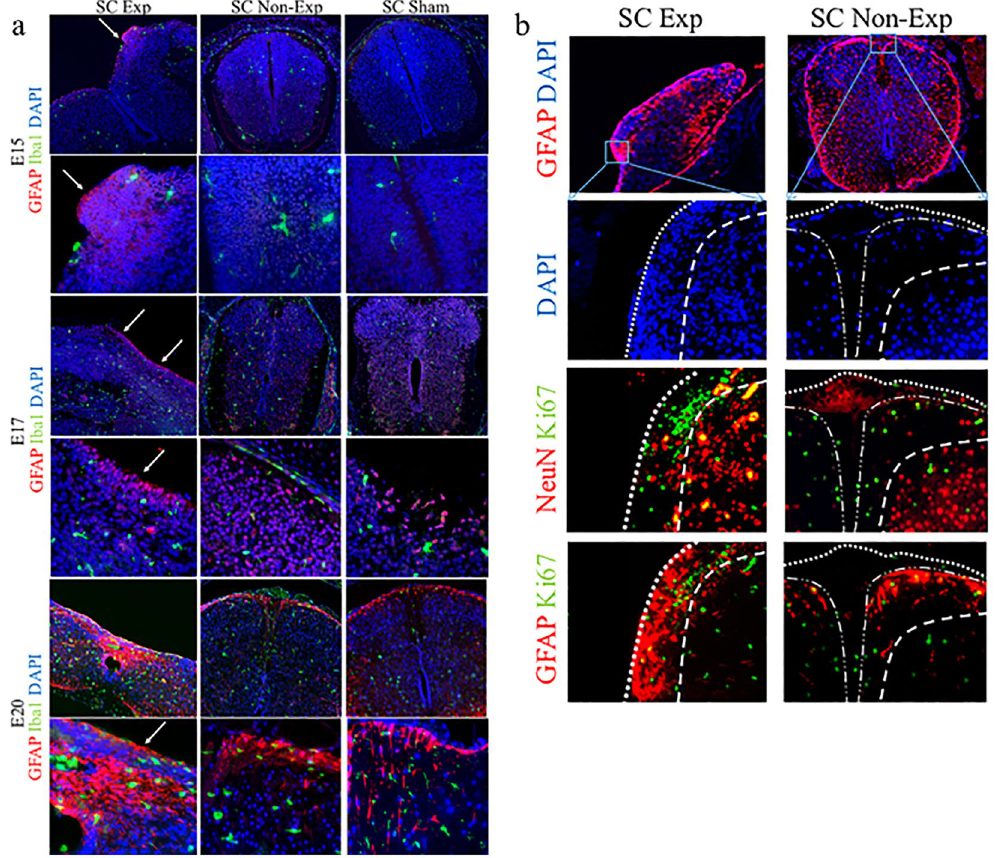
E17, and E20 in spina bifida exposed spinal cords (arrows). Reactive microglia stained with Iba1 (green) and DAPI (blue). ( b ) GFAP-immunoreactive GFAP (red) and DAPI (blue) coronal section (10 × ). Immunoreactive and proliferative (green) astrocytes in exposed layers in aggregates (40 × ). No patterned neural distribution in exposed spinal cords in spina bifida fetuses stained with NeuN (red)(40 × ). Proliferative astrocytes GFAP (red) colocalized with Ki67 (green) in spinal cords exposed in spina bifida fetuses at